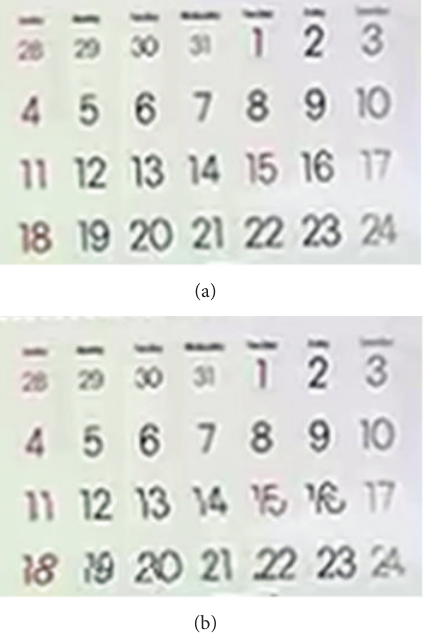
Table 5: Results of video quality test.